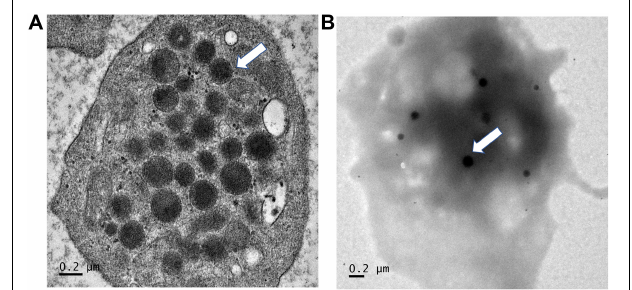
FIGURE 7 | Electron microscopy findings of platelets. Platelet transmission electron microscopy (Phillips 301 electron microscope; F.E.I., Hillsboro, OR, United States) study of patients 2 and 3, using whole-mount method (White, J. G., 2008). (A) Note normal numbers of alpha granules (normal range 30–50 per platelet). (B) Normal number of dense granules (in 30 healthy subjects, 2.4–3.7 per platelet). Magnification × 25,